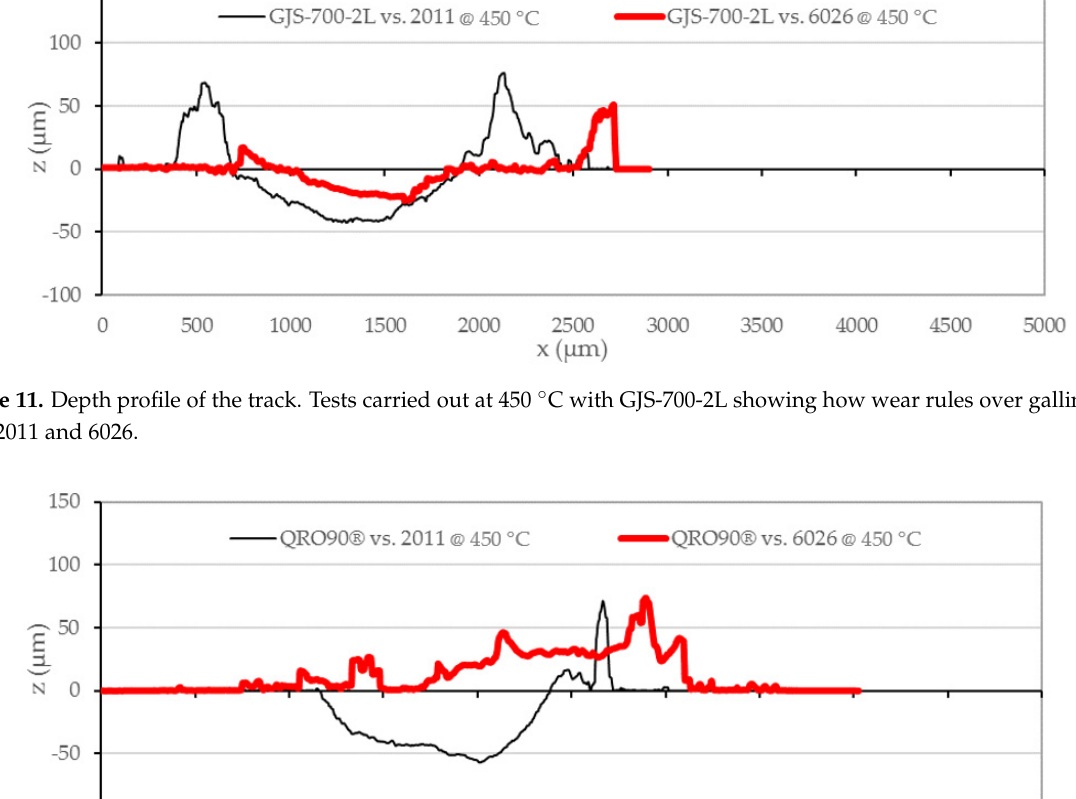
Figure 11. Depth profile of the track. Tests carried out at 450 °C with GJS-700-2L showing how wear rules over galling both with 2011 and 6026.